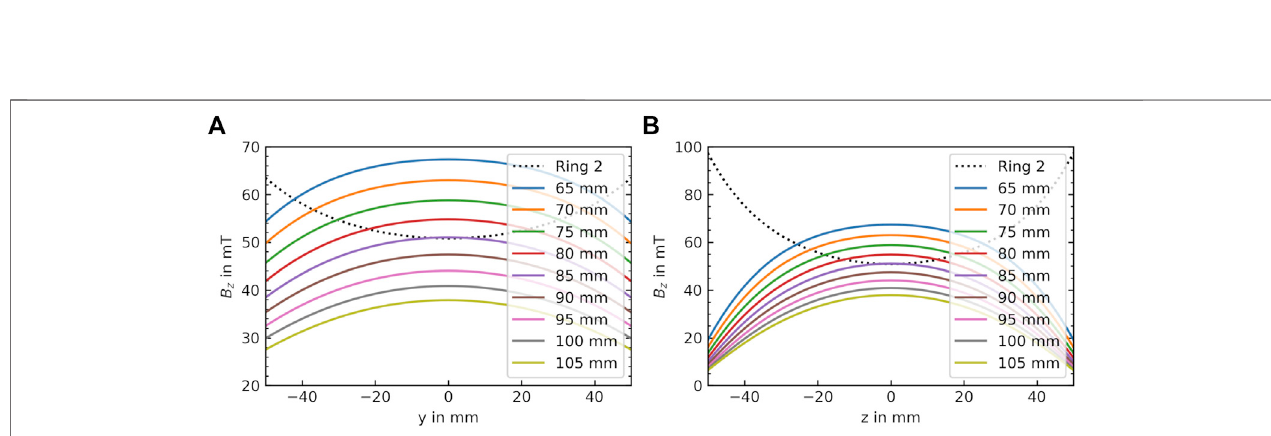
FIGURE 3 | Optimization procedure of the base magnet to determine the optimal distance between the rings. Simulations of the magnetic fl ux densities of Ring 1 and3basedonthedistancebetweentherings(d1in Panel1F )along (A) y-directionand (B) z-direction.Themagnetic fl uxdistributionfromRing2(centralring)isplotted asablackdottedline.TheconcavecurvaturegeneratedbytheRing1andRing3con fi gurationcanbecompensatedtosomeextentbytheconvexcurvatureofRing2in order to homogenize B z .